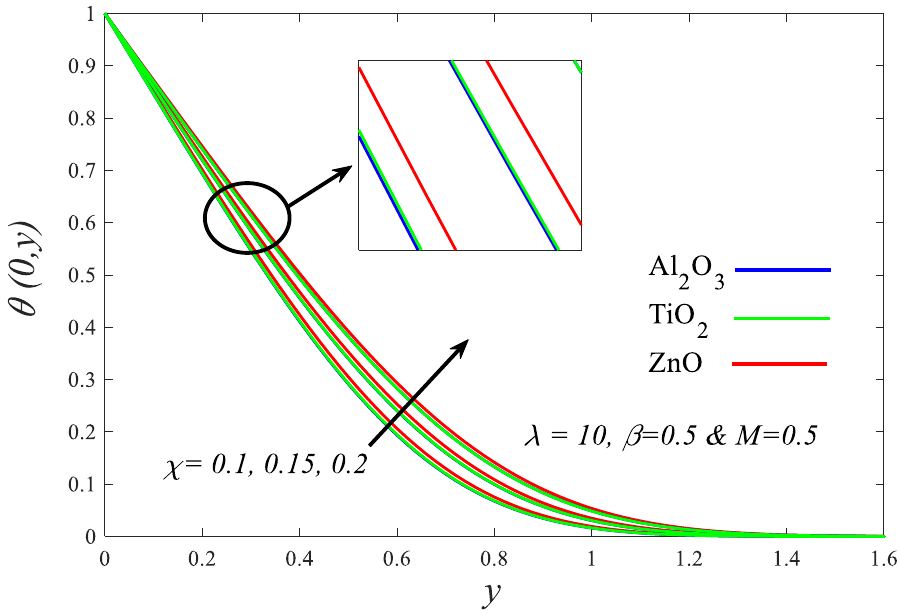
 Figure 12. Impression of χ on θ . The inset is a partial enlargement of the Figure 12. Impression of  on . The inset is a partial enlargement of the curves.